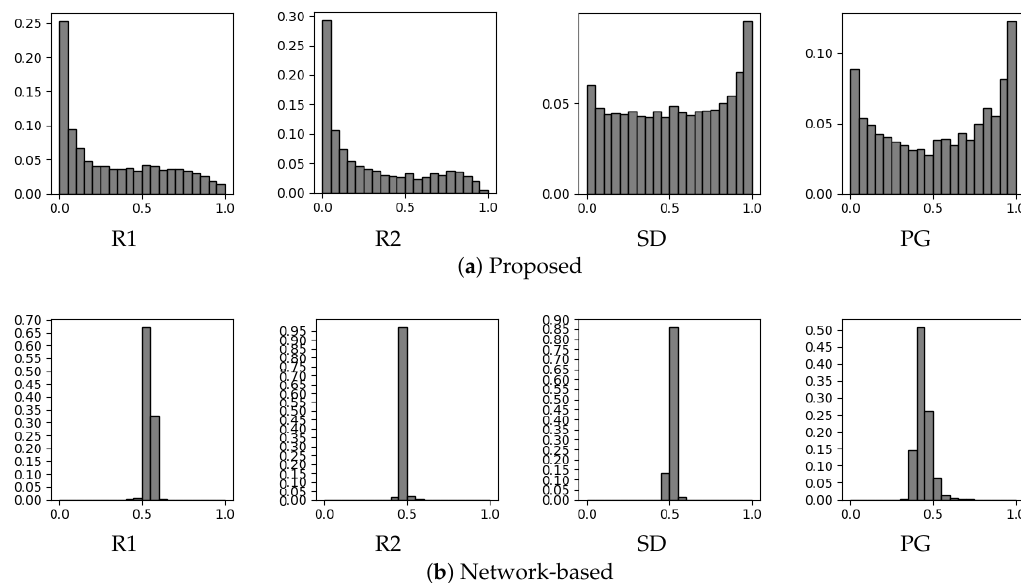
Figure 9. Topic distributions of articles. The distribution of the proposed method is much